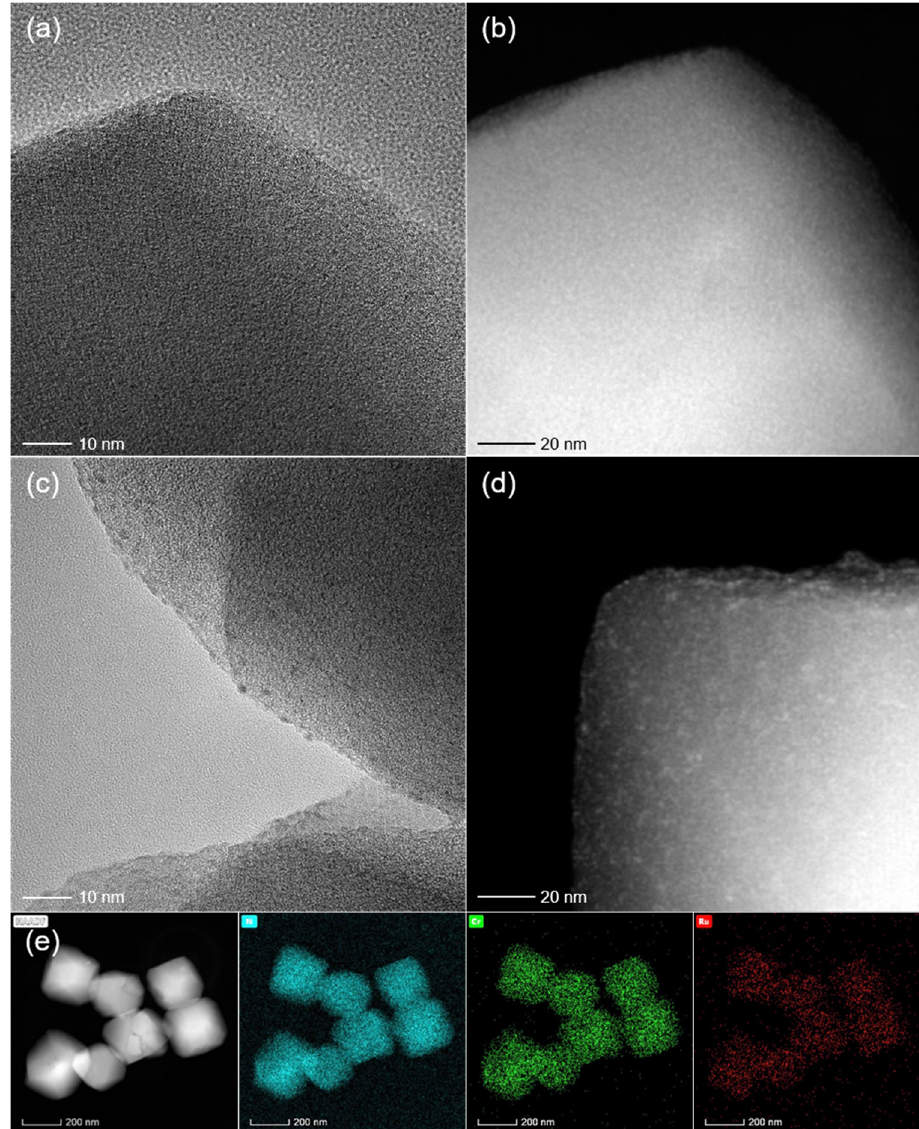
Figure 2. ( a ) TEM and ( b ) STEM images of Ru 3 -ED-MIL-101(Cr). ( c ) TEM and ( d ) STEM images of Ru/ED-MIL-101(Cr). ( e ) EDS maps of Ru/ED-MIL-101(Cr). N (cyan), Cr (green), and Ru (red) are indicated.